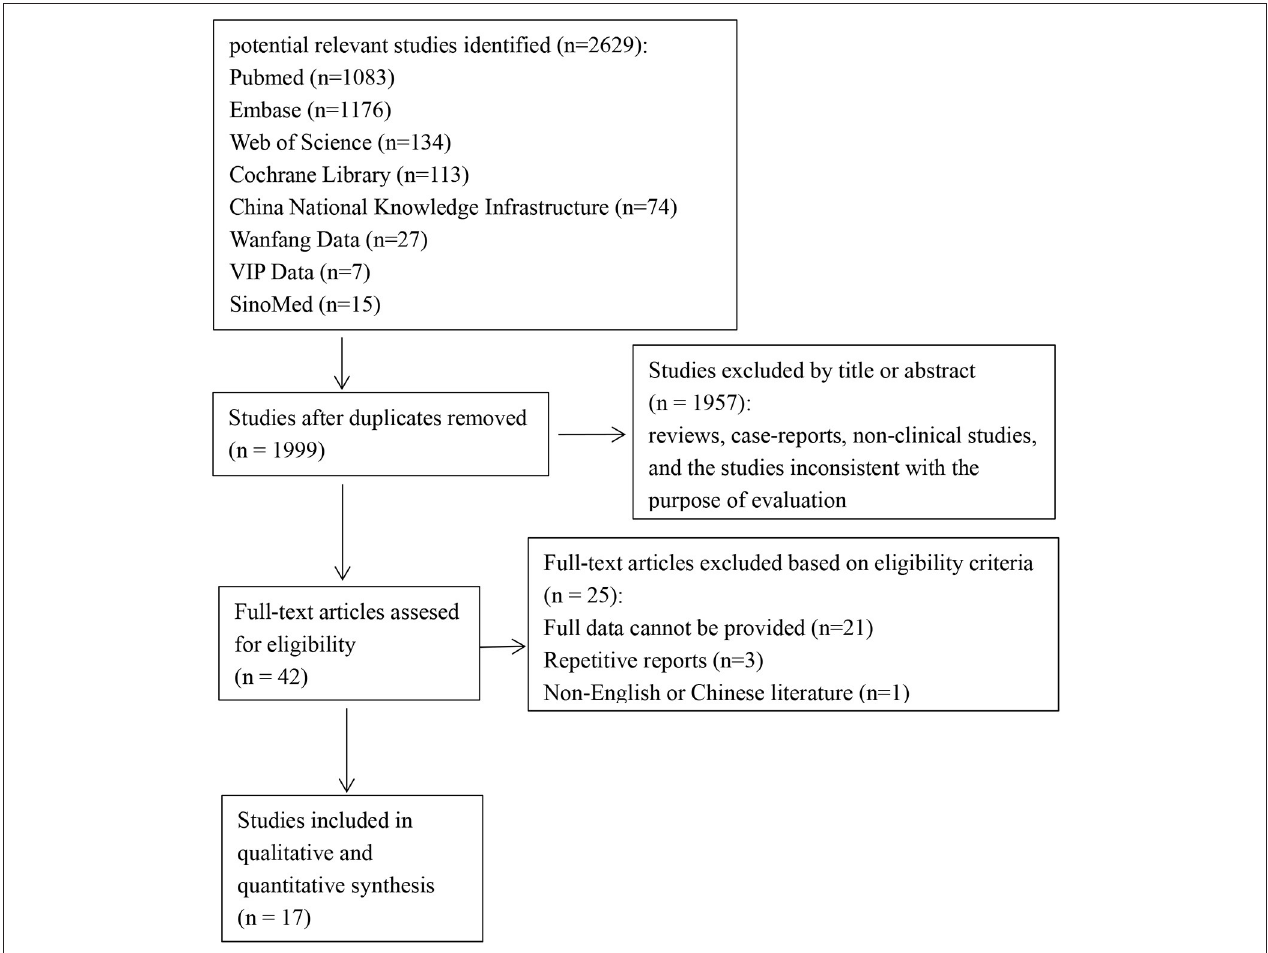
FIGURE 1 | Flowchart of the selection process for eligible studies [the preferred reporting items for systematic reviews and meta-analyses (PRISMA) 2009 flow